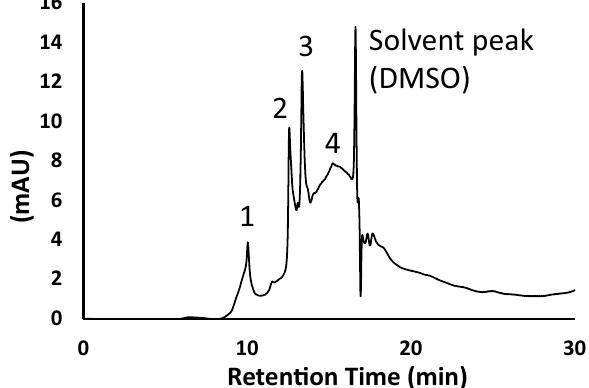
Figure 7. A typical HPLC separation of date fruit melanin on C18 reversed phase column using water: methanol; acetic acid (90: 10: 1, v/v/v) at o.2 mL/min as mobile phase and detection at 280 nm. Four peaks were detected with the last one eluting as a broad peak.